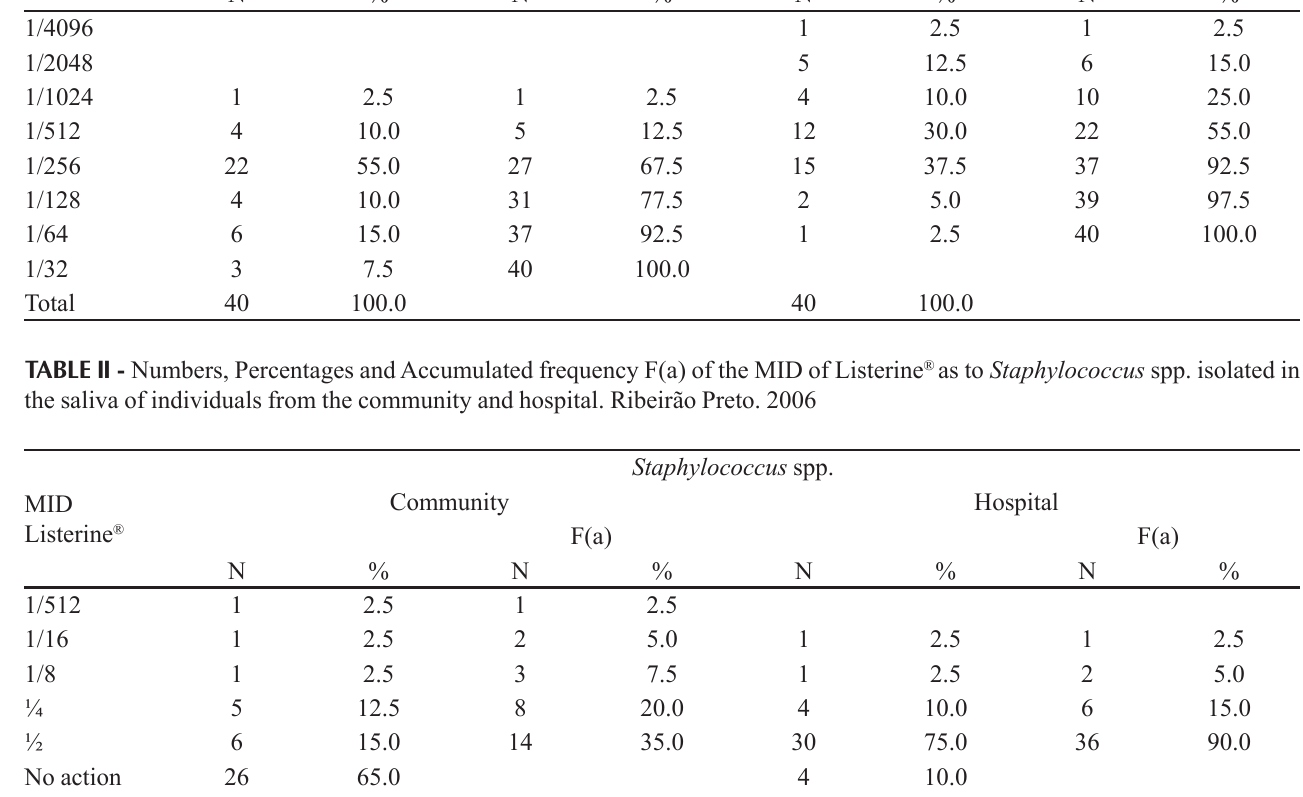
TABLE I - Numbers, Percentages and Accumulated frequency F(a) of the MID of CPC mouthwash as to Staphylococcus spp. isolated in the saliva of individuals from the community and hospital. Ribeirão Preto. 2006